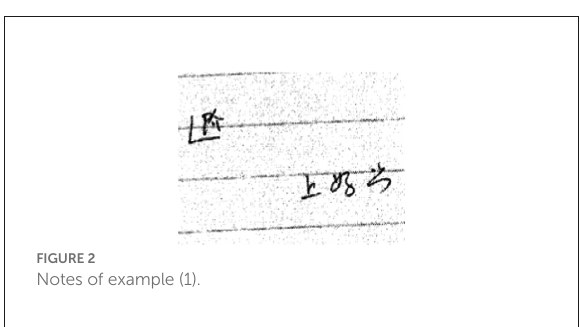
FIGURE 2 Notes of example